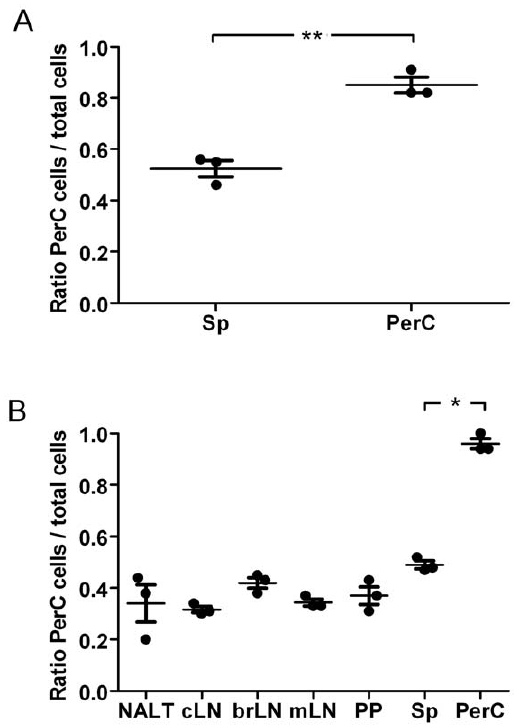
Figure 5. Peritoneal CD4 + T cells preferentially re-enter the peritoneal cavity. (A) CXCR3 + or (B) CXCR3 2 CD4 + T cells isolated from spleen or peritoneal cavity were differentially labeled with CFSE or CMTMR, and mixtures containing equal numbers of cells were injected intravenously into naı¨ve recipients. 18 hours after transfer, the ratio of transferred peritoneal cells to total transferred cells (peritoneal cells + spleen cells) was determined in different organs by flow cytometry. Similar results were obtained in three independent experiments. Dots represent the ratio for individual animals. Horizontal lines indicate the mean for the group, and error bars correspond to the SEM. The differences were statistically significant at P , 0.0001 (*) and P , 0.002 (**). NALT, nasal associated lymphoid tissues; cLN, cervical lymph node; brLN, bronchial lymph node; mLN, mesenteric lymph node; PP, Peyer’s patches; Sp, spleen; PerC, peritoneal cavity. doi:10.1371/journal.pone.0018032.g005 Figure 6. Th cell subsets are differentially distributed in